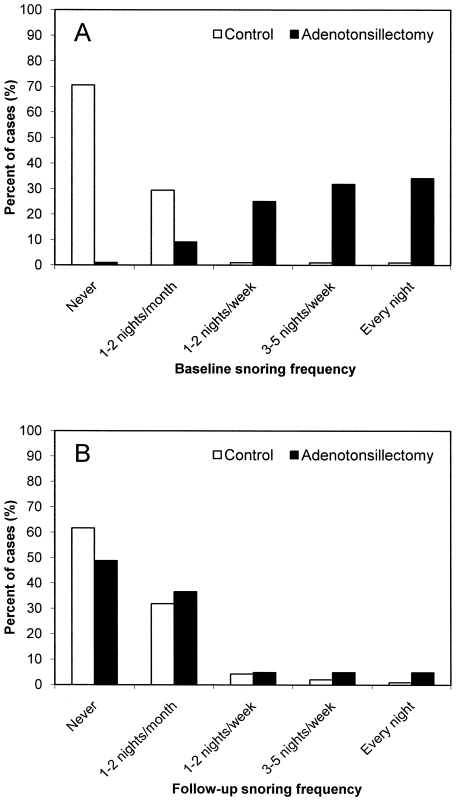
Parentally reported snoring frequency for controls and children awaiting adenotonsillectomy.Children scheduled for adenotonsillectomy were reported by parents to snore more frequently compared to controls, χ2 = 79.7, p<.001 (Figure 1A). At 6 months follow-up, snoring frequency was not significantly greater amongst children who underwent adenotonsillectomy compared to controls, χ2 = 3.8, p = 0.433 (Figure 1B).